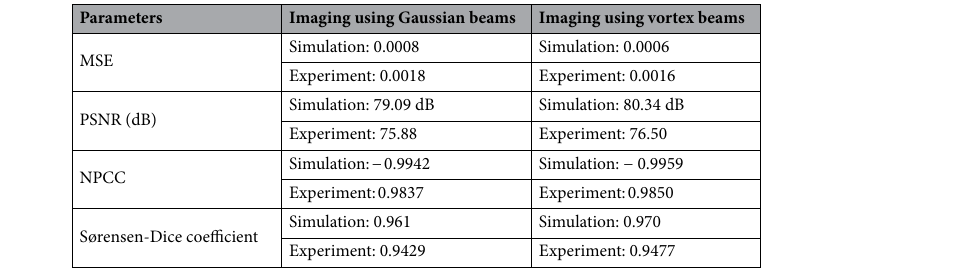
Table 1. Image enhancement using vortex beams and deep